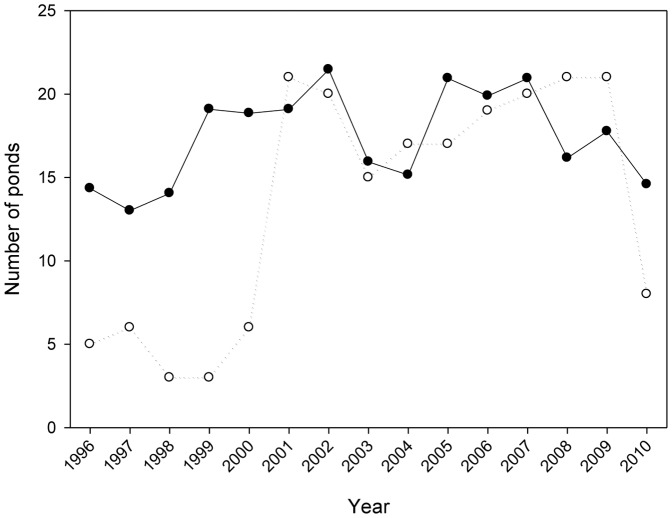
Comparison of number of ponds occupied by Pseudacris triseriata versus those suitable across years.Open symbols and dashed line are ponds occupied and closed symbols and solid line are number of ponds deemed suitable habitat. Ponds estimated as suitable were 1) open-canopy ponds that dried the previous fall, 2) open-canopy ponds that did not dry the previous fall, and 3) closed-canopy ponds, respectively, weighted by the frequency of occupancy in the 2001 to 2008 period, and summed (see Methods for details).